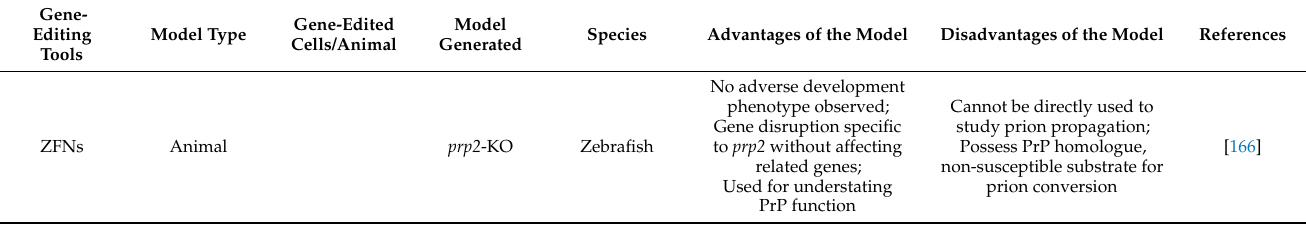
Table 2. Gene-editing tools employed in prion